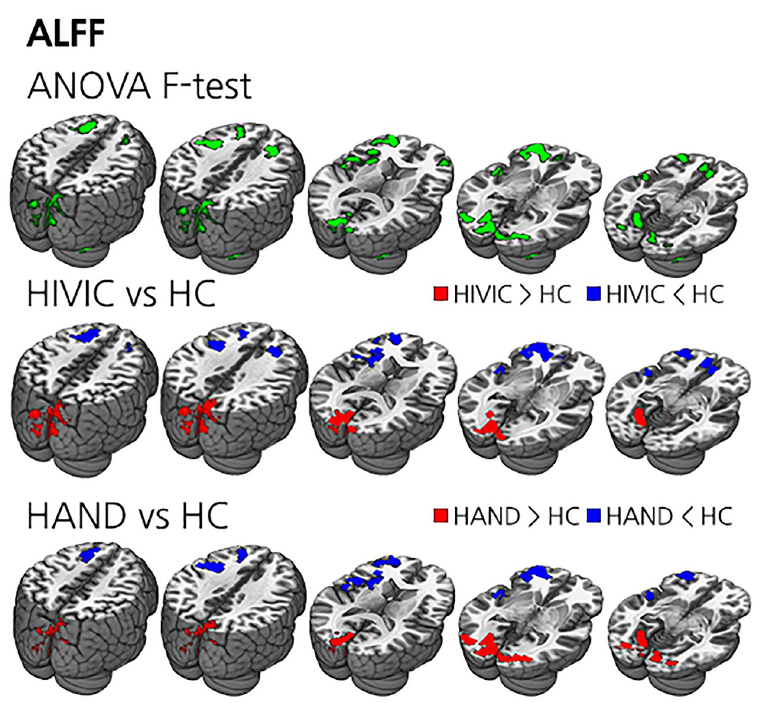
Fig 2. The results of ALFF analysis. (Top) ANOVA results between HAND, HIV-IC and HC. Green clusters are voxels with significant ANOVA results. (Middle) t -test results between HIV-IC and HC. Blue clusters represent lower ALFF regions of HIV-IC and red clusters represent the opposite. (Bottom) t -test results between HAND and HC. Blue clusters represent lower ALFF regions of HAND and red clusters represent the opposite. There was no significant voxel in comparison between HAND and